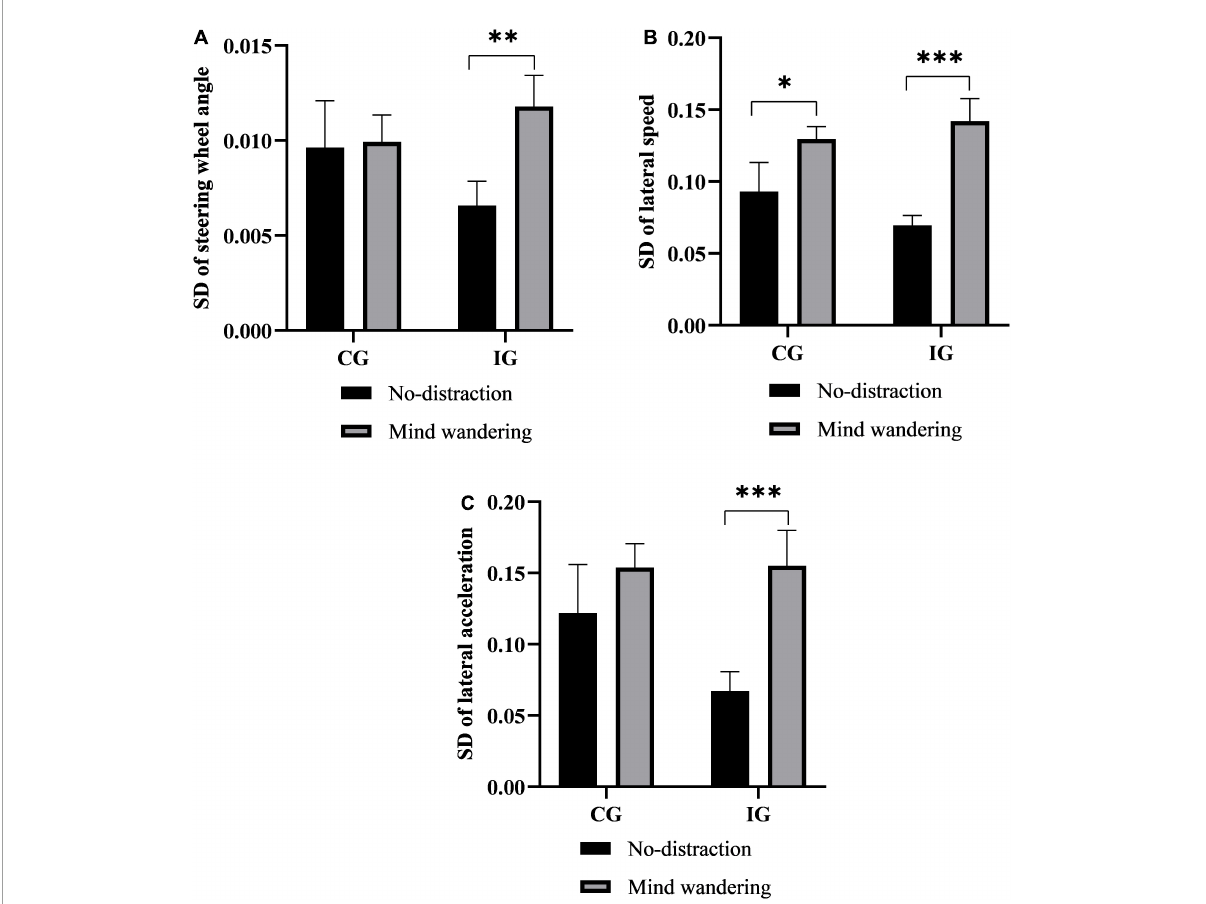
FIGURE5 The effect of MW on lane-changing control. (A) SD of steering wheel angle. (B) SD of lateral speed. (C) SD of lateral acceleration. ∗∗∗ P < 0.001; ∗∗ P < 0.01; and ∗ P < 0.05. MW, mind wandering; SD, standard deviation; IG, insomniac group; CG, control group.